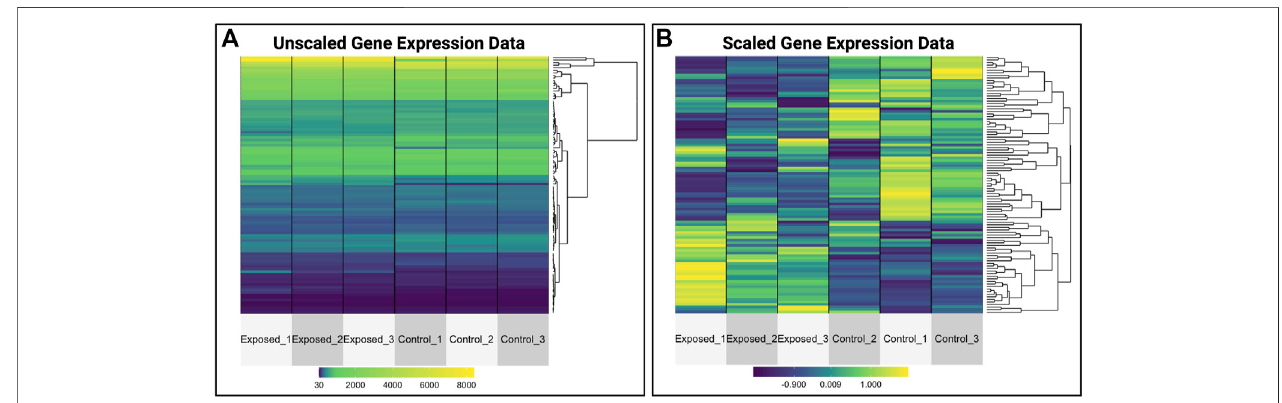
FIGURE10| Heatmapvisualizationsofgeneexpression datathatareproduced asexampleswithintheGEOtrainingmodule. Thistrainingmoduleguidestrainees throughvisualizingnormalizedgeneexpressiondataandhighlightsthedifferencesbetweenplotting (A) unscaledversus (B) scaledvalues.Thisexampleshowstheutility of scaling data prior to visualizations, allowing for improved visualizations of patterns between samples.